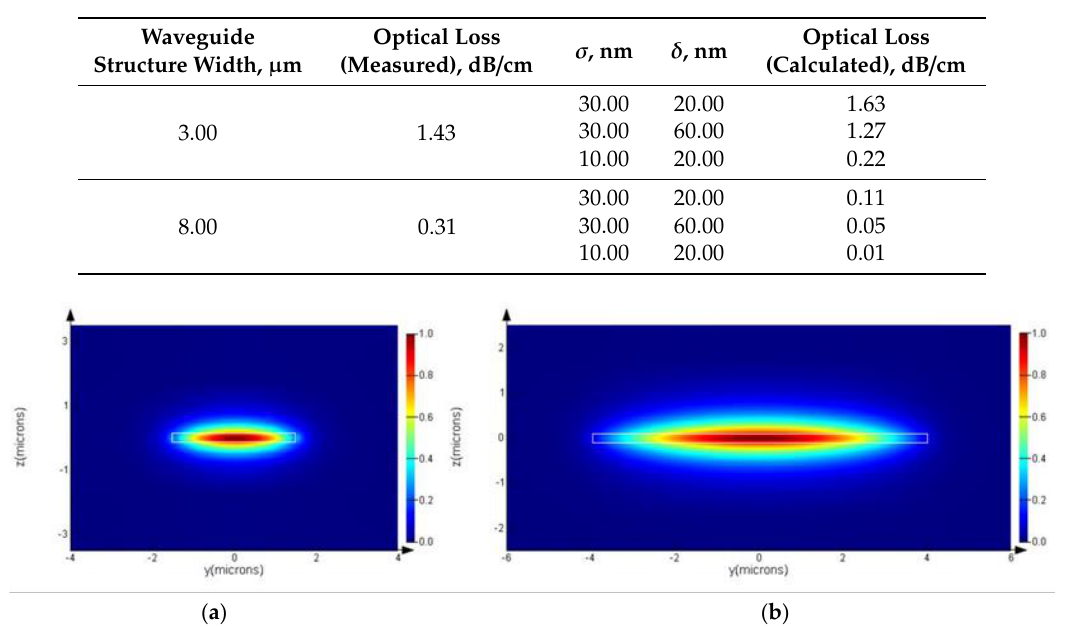
Table 3. Comparison of the measured and calculated attenuation of the TE00 mode in silicon nitride waveguides; σ —mean square deviation of roughness; δ —longitudinal size of roughness.